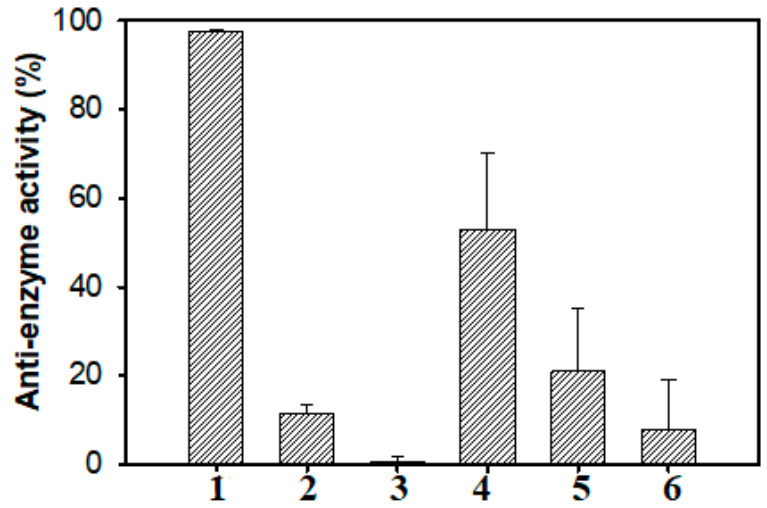
Figure 8. Effect of TKU004P on different enzymes. 1 —yeast α -glucosidase; 2 —rat α -glucosidase; 3 —porcine pancreatic α -amylase; 4 — B . subtilis α -amylase; 5 —lysozyme; 6 —cellulose.